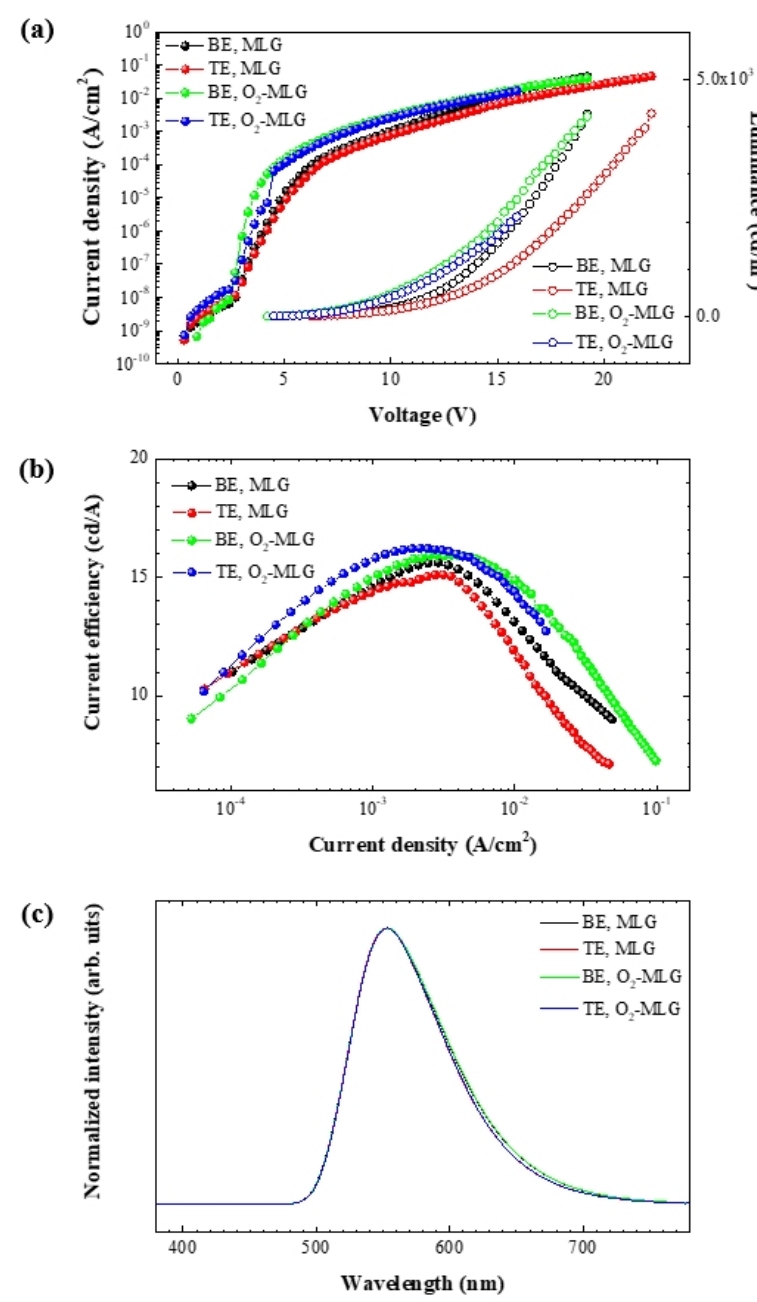
Figure 2. ( a ) J–V–L, ( b ) EL and ( c ) η LCE characteristics of MLG and O 2 -MLG Table 1. J–V–L characteristics of MLG and O 2 ‐ MLG TOLEDs.